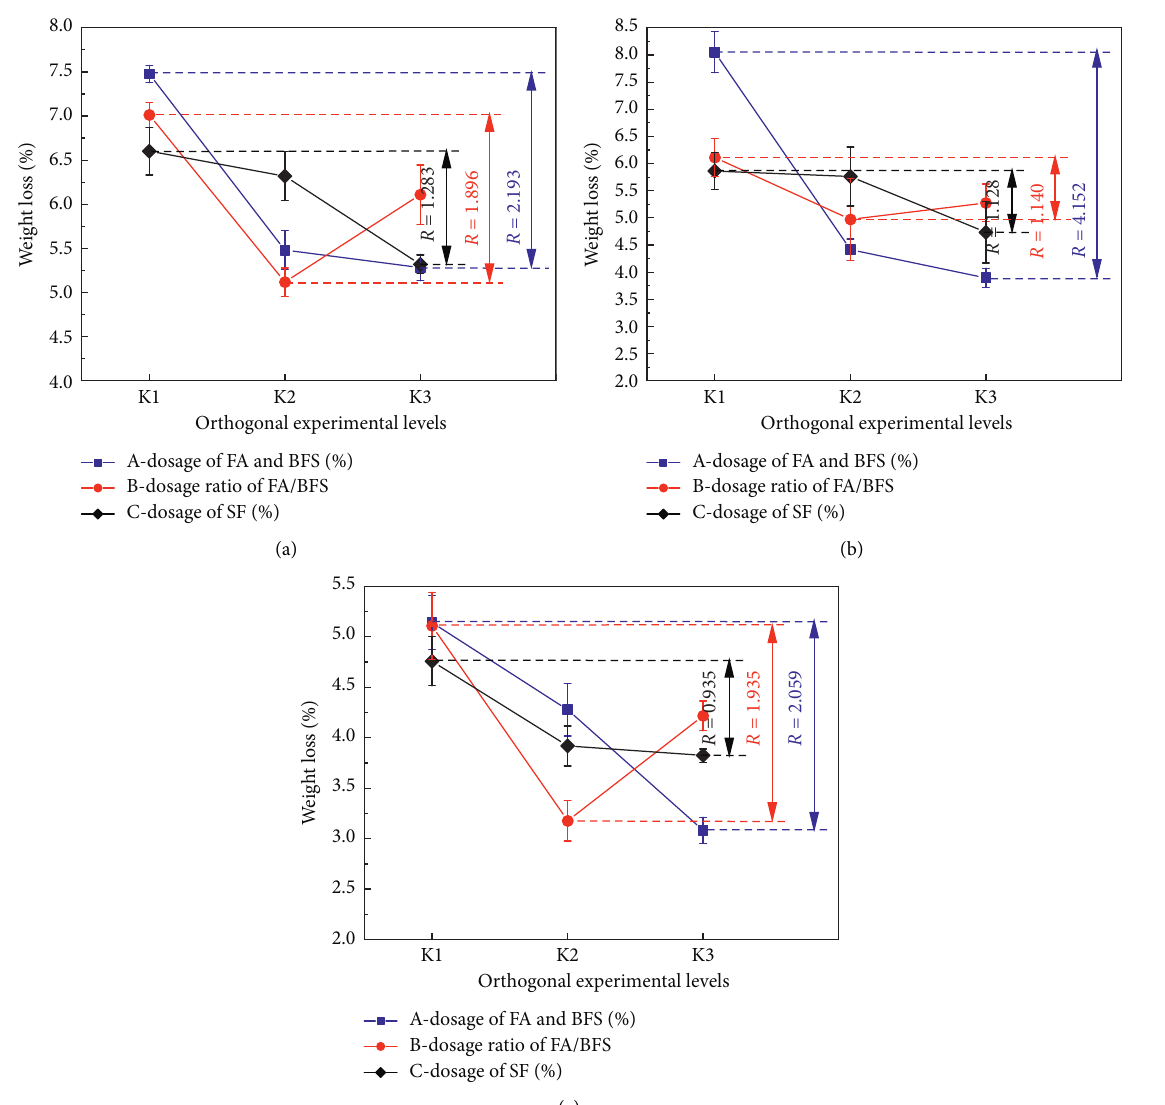
Figure 7: Range analysis between weight loss and orthogonal experimental levels of cement concrete. (a) Air content of (2.5 ± 0.5)%. (b) Air content of (4.5 ± 0.5)%. (c) Air content of (6.5 ±